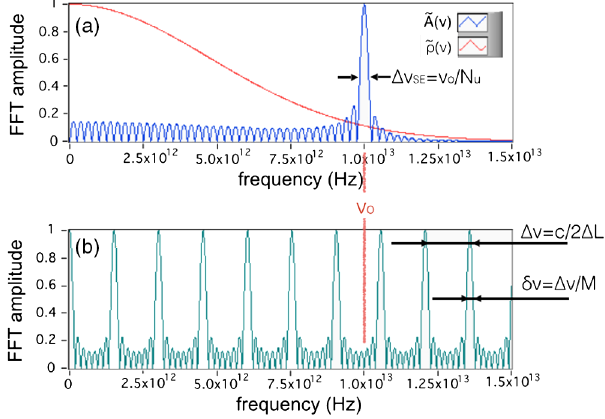
FIG. 8. (a) The blue curve is the analytical calculation of e A coherent emission ð ν Þ for a single electron bunch with σ 33 fs, λ ¼ 30 μ m, and N 40 , peaking at ν 10 13 Hz, t ¼ u ¼ o ¼ and the red curve is the amplitude spectrum. ˜ ρ ð ν Þ from a Gaussian electron bunch; and (b) is the periodical distribution ( Ш (cid:3) sinc) due to cavity accumulation of light pulses, exhibiting a series of peaks on ν n , with M ¼ 10 here to allow the clearest view (on CLIO we have M ¼ 300 ).